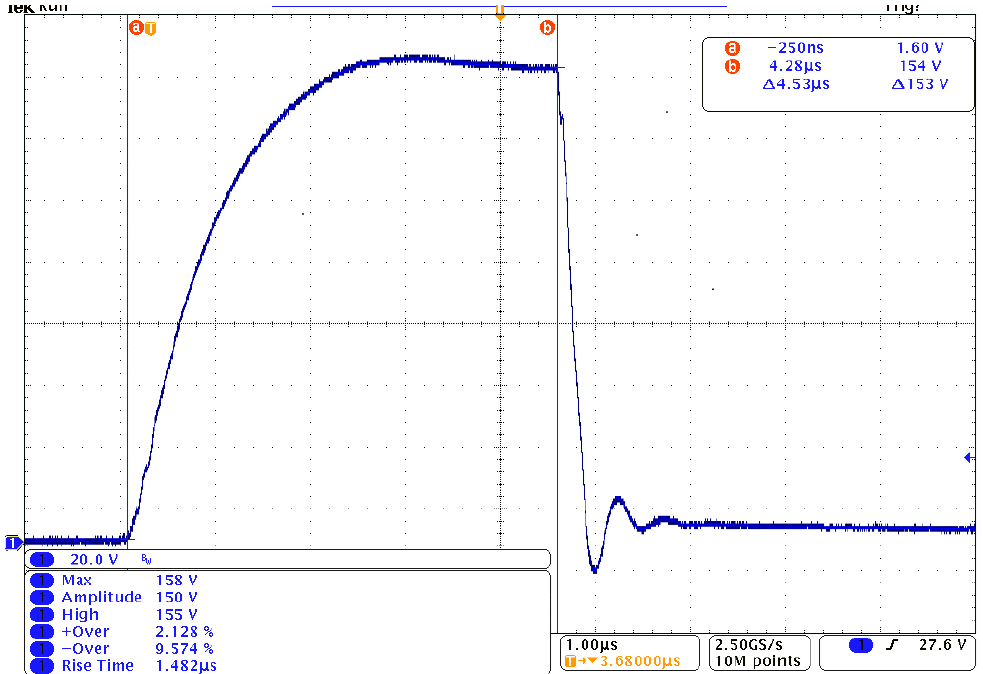
Figure 9. Waveform of voltage as a result of applying a negative lightning impulse voltage to the